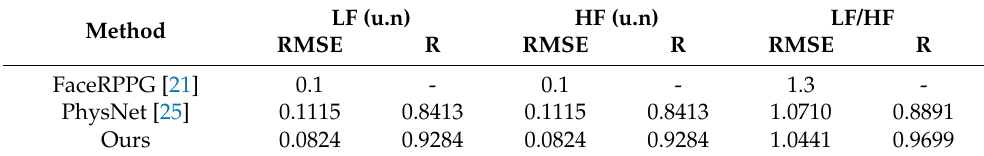
Table 5. The result of frequency-domain metrics on the PURE